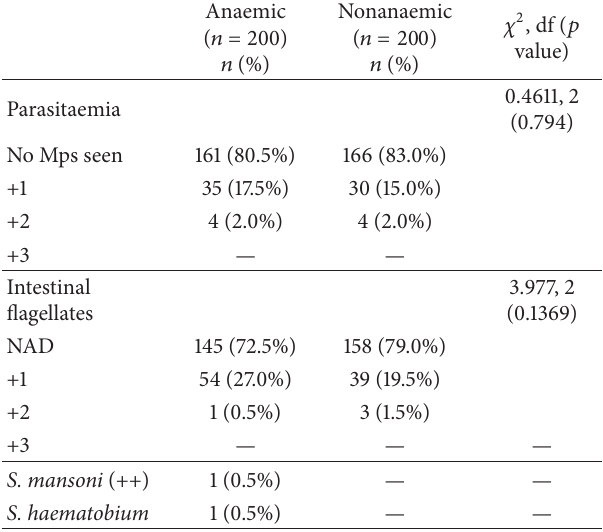
Table 3: Malaria parasitaemia in anaemic and nonanaemic preg- nant